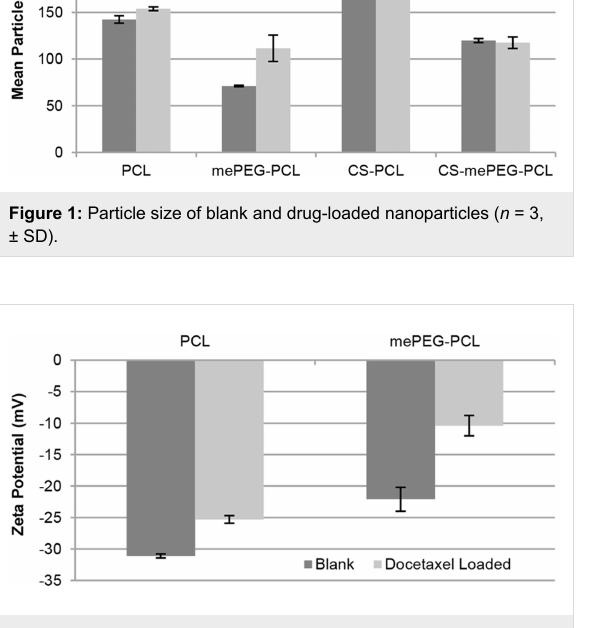
Figure 2: Zeta potential of blank and drug-loaded nanoparticles ( n = 3, ± SD).